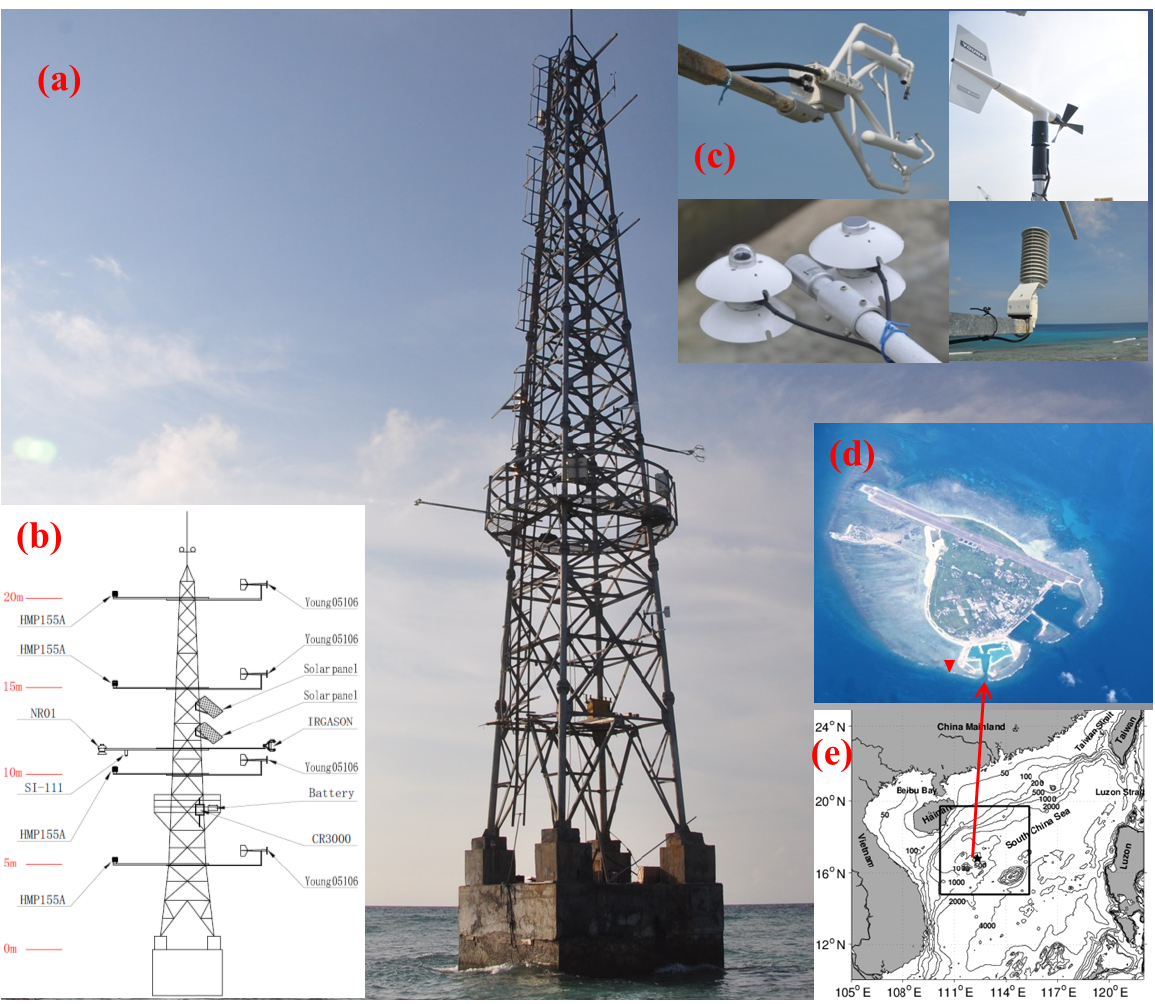
Figure 1. (a) Yongxing Island air–sea flux tower (YXASFT). (b) Instrumentation and data acquisition system mounted on the YXASFT. (c) Pictures of some sensors on the YXASFT. (d) Google satellite image of Yongxing Island. The red triangle indicates the location of the YXASFT. (e) Map of the northern SCS. The black star indicates the location of Yongxing